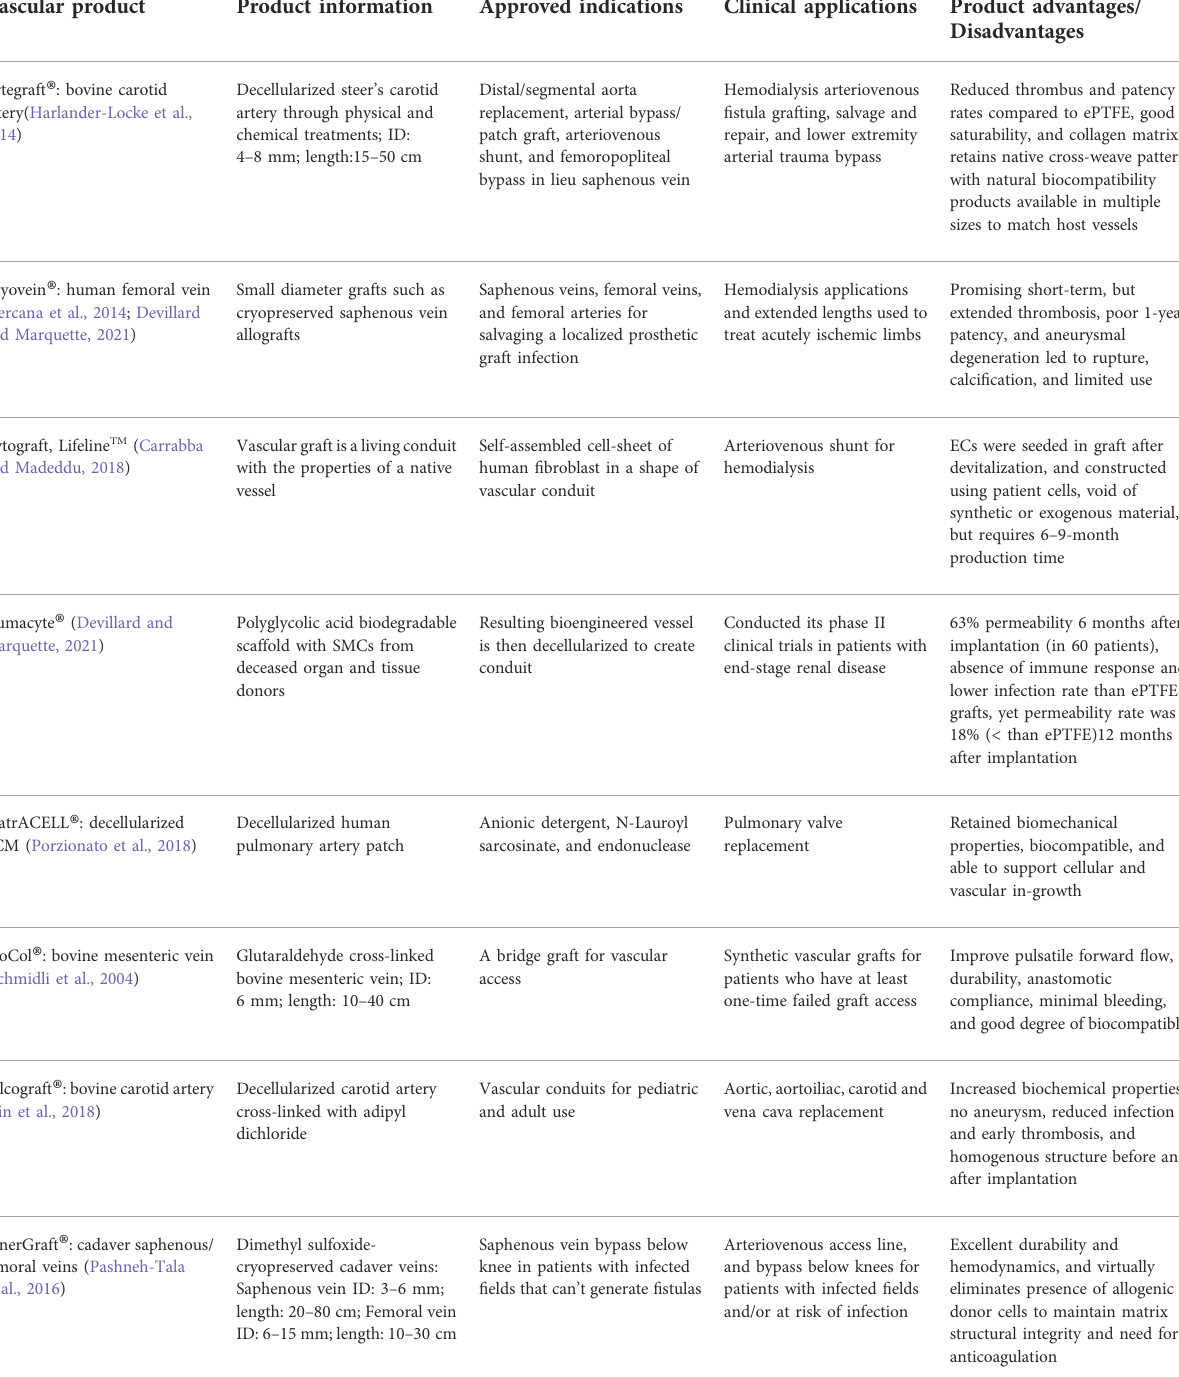
TABLE 2 A summary of commercially available decellularized vascular products, their associated applications, and clinical